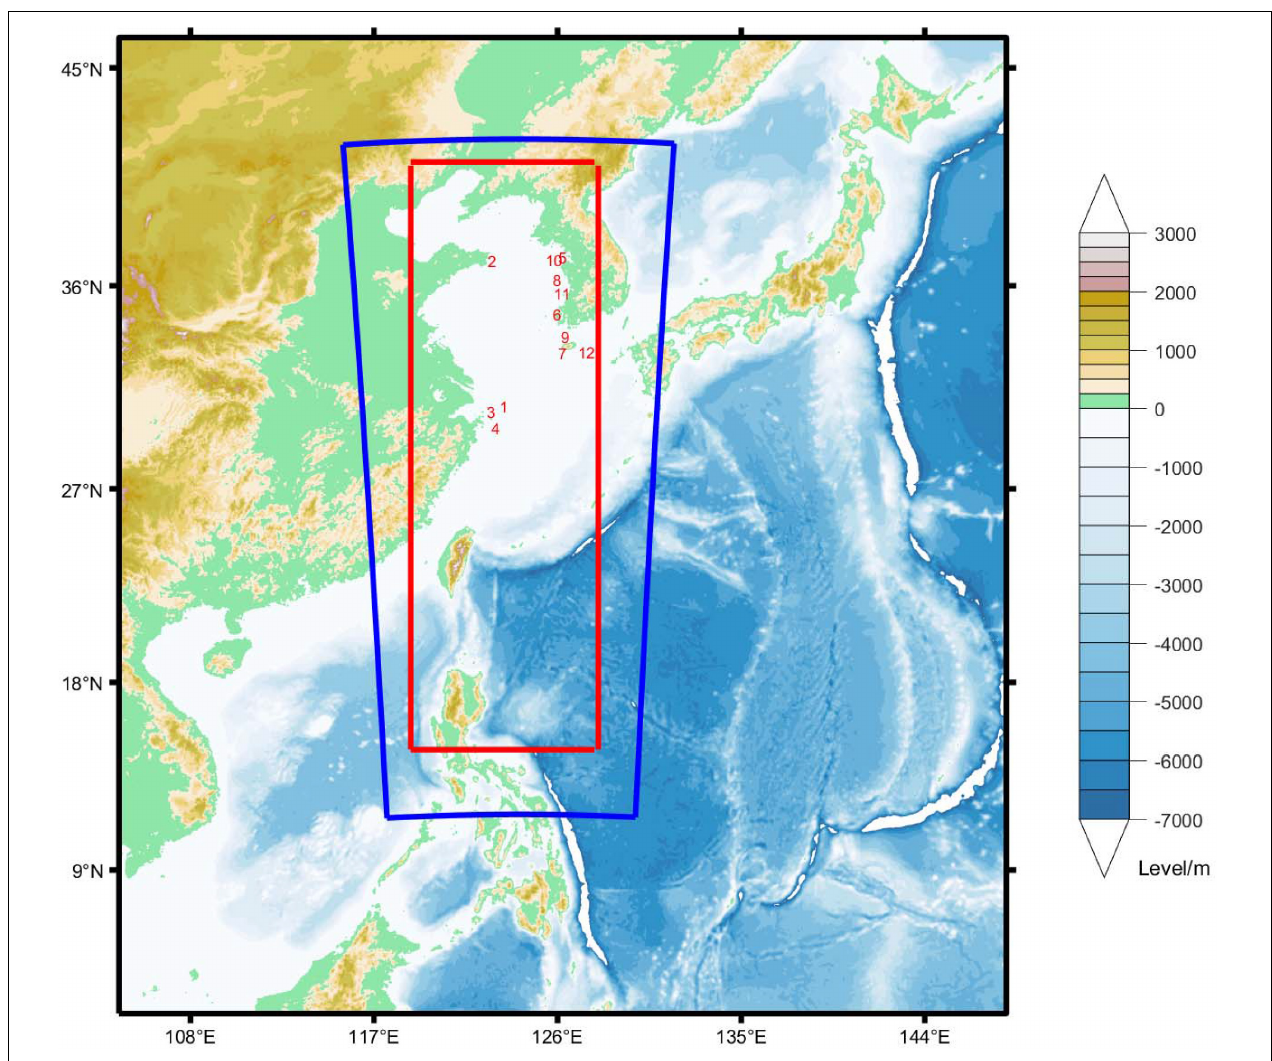
FIGURE 1 | Topography of model areas: The outermost square indicates a domain for WAM simulation over the northwest Pacific region (resolution: 0.1 ◦ ), the red square indicates the region for fine-resolution (0.05 ◦ ) WAM simulation and CCLM-WAM coupling nested within the northwest Pacific WAM, and the blue square is the domain of CCLM simulations. Numbers in red indicate the locations of buoy observations (refer to Supplementary Table 1 for details).